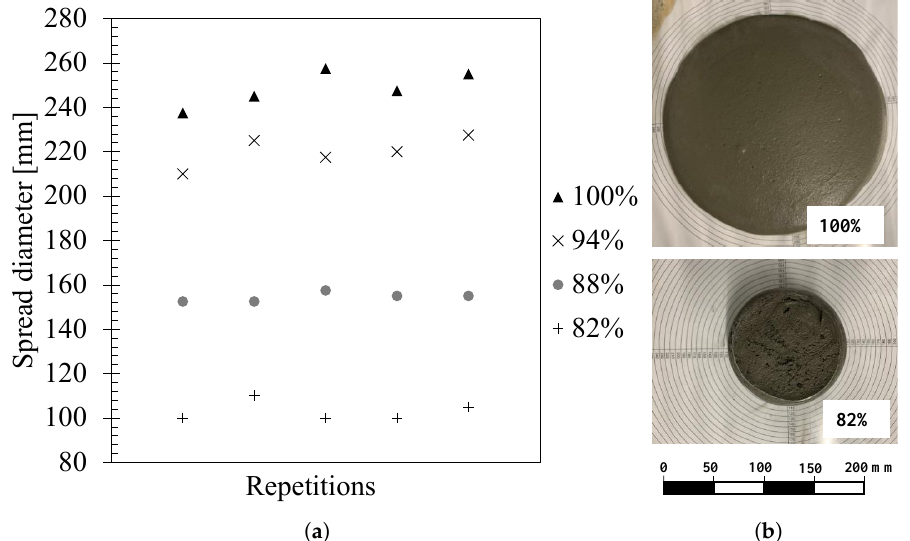
Figure 1. ( a ) Effect of HRWR on slump flow diameter, and ( b ) Spread diameter with HRWR content of 100% and